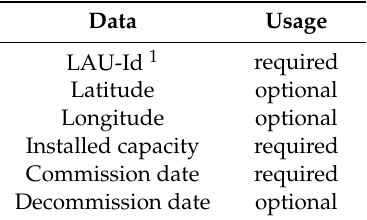
Table 1. Content of the plant dataset used as input data for the photovoltaic (PV) model.